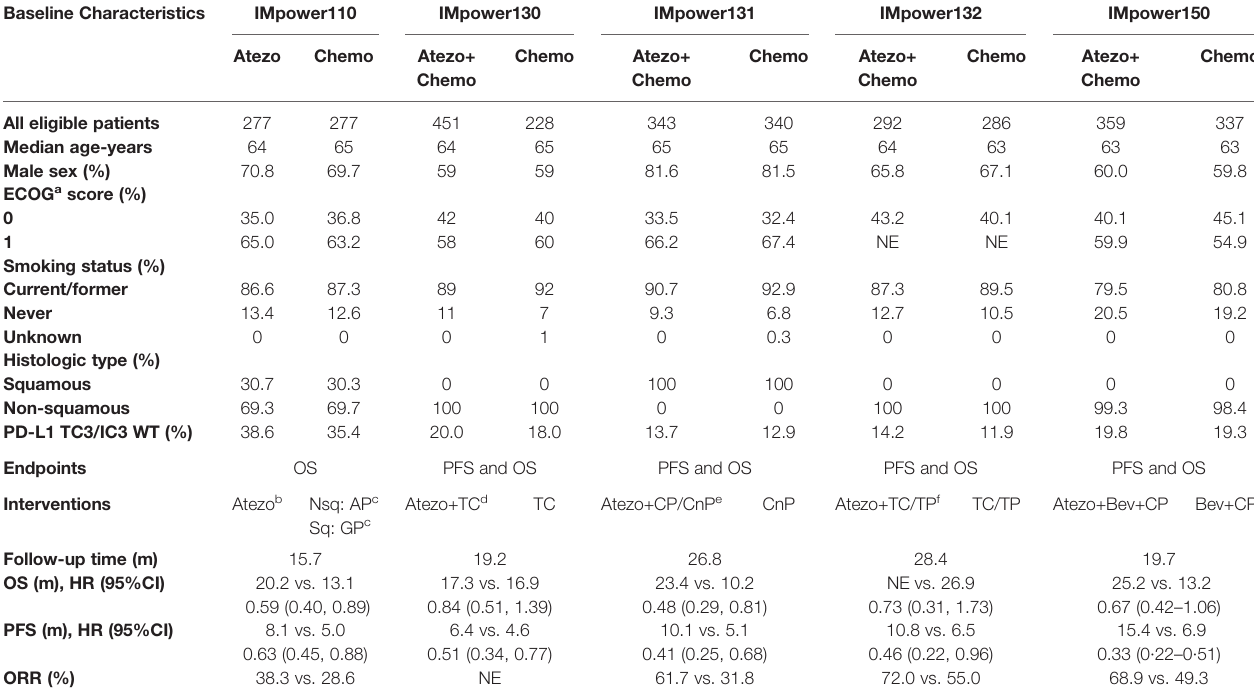
TABLE 1 | Baseline characteristics and available endpoints of PD-L1 TC3/IC3 WT patients in included trials Baseline